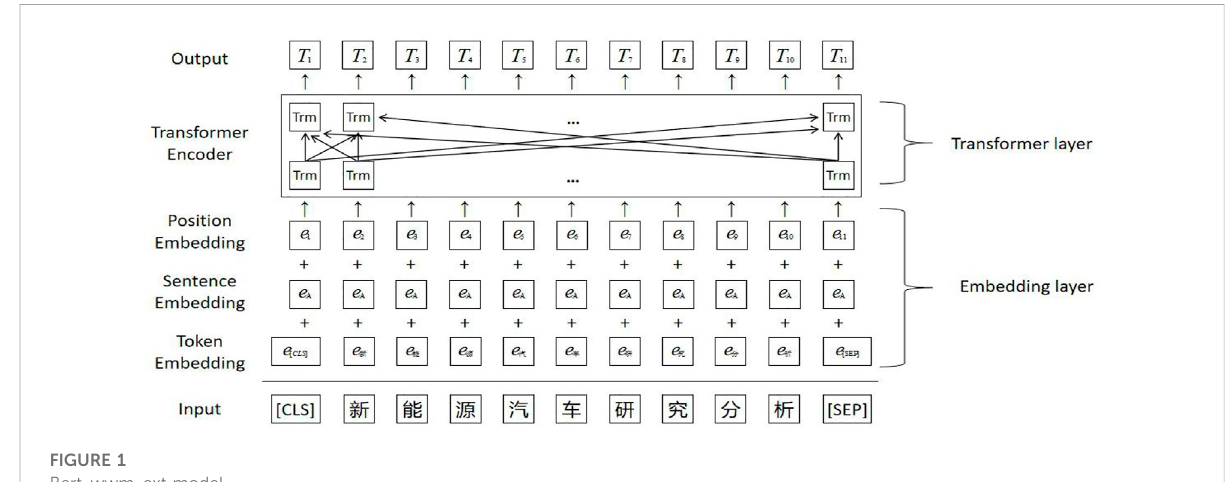
FIGURE 1 Bert-wwm-ext